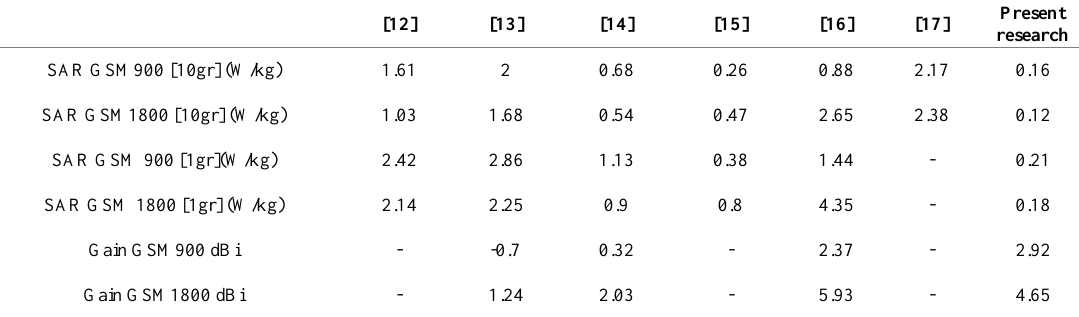
Table 6. Comparison between